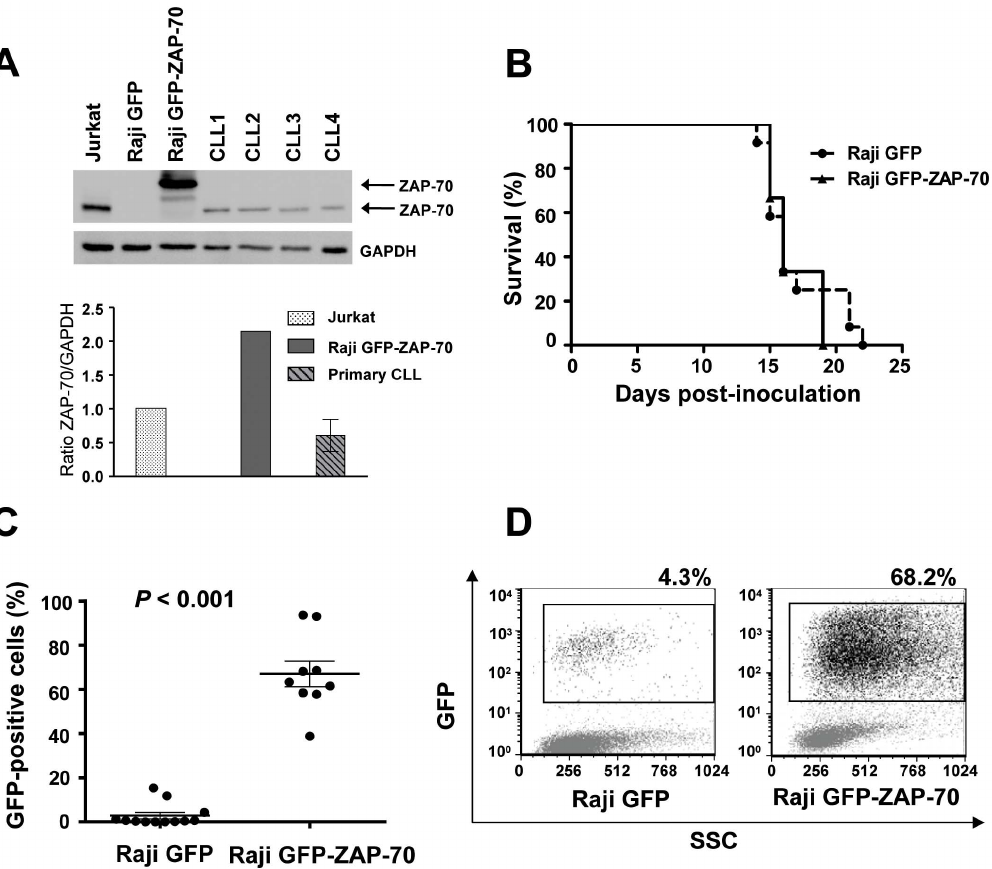
Figure 1. ZAP-70 ectopic expression enhances the capacity of malignant B-cells to infiltrate the bone marrow. SCID mice were intravenously injected with 2 6 10 6 stably transfected Raji cells (12 mice with control Raji GFP cells and 9 mice with Raji GFP-ZAP-70 cells). (A) ZAP-70 expression levels were compared by western blotting in Raji transfectants and primary CLL samples. (B) Survival curves according to Kaplan and Meier method. (C) Percentage of GFP-positive cells as assessed by flow cytometry in the bone marrow from mice injected with Raji GFP-ZAP-70 cells (n=9) and Raji GFP cells (n=12). Graph shows the mean percentage 6 SEM (D) Flow cytometry dot plot showing percentage of GFP-positive cells in the bone marrow from two representative mice.